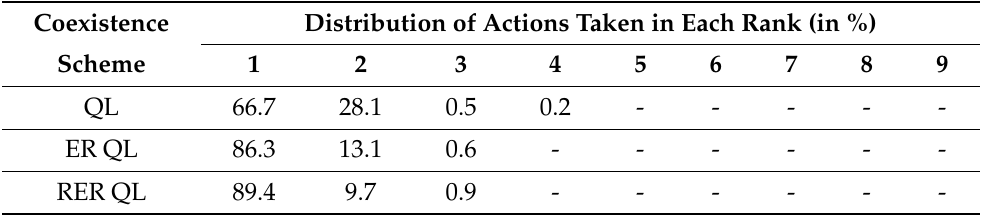
Table 4. Distribution of rank of actions taken based on the Q-learning, ER Q-learning, and RER Q-learning based